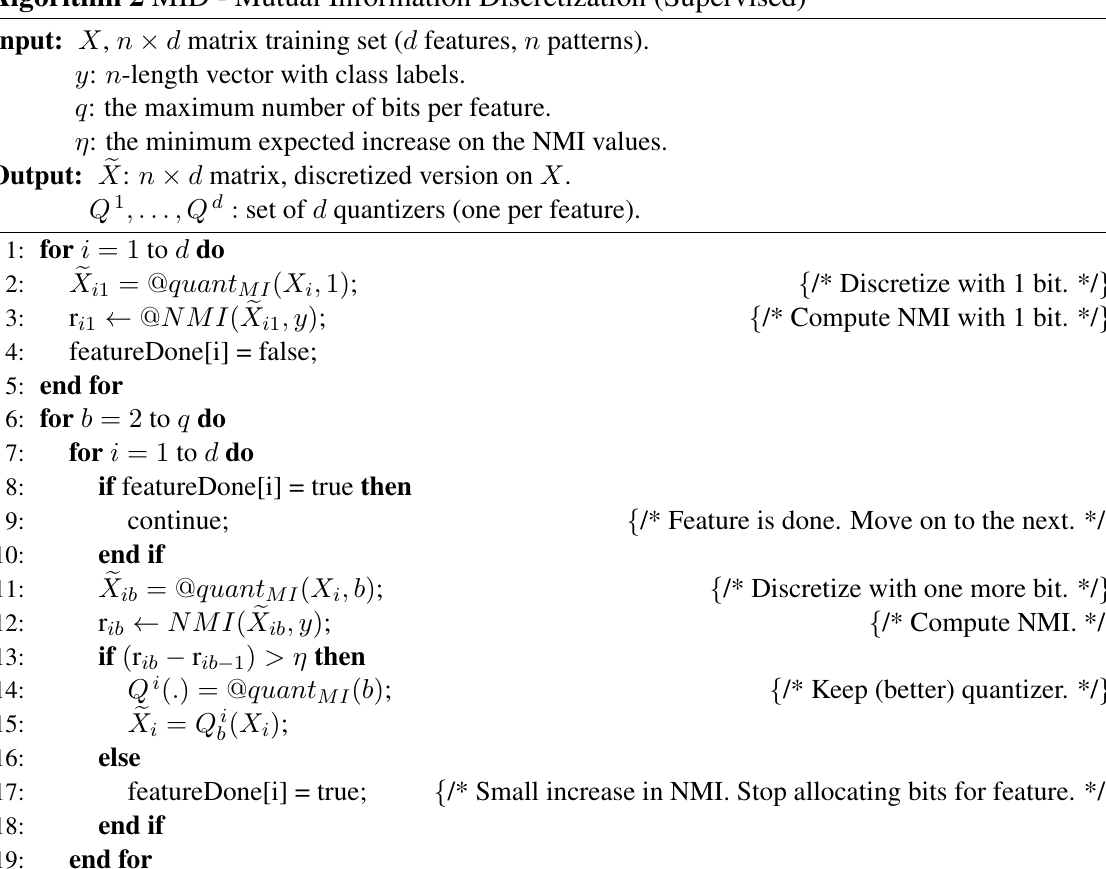
Algorithm 2 MID - Mutual Information Discretization